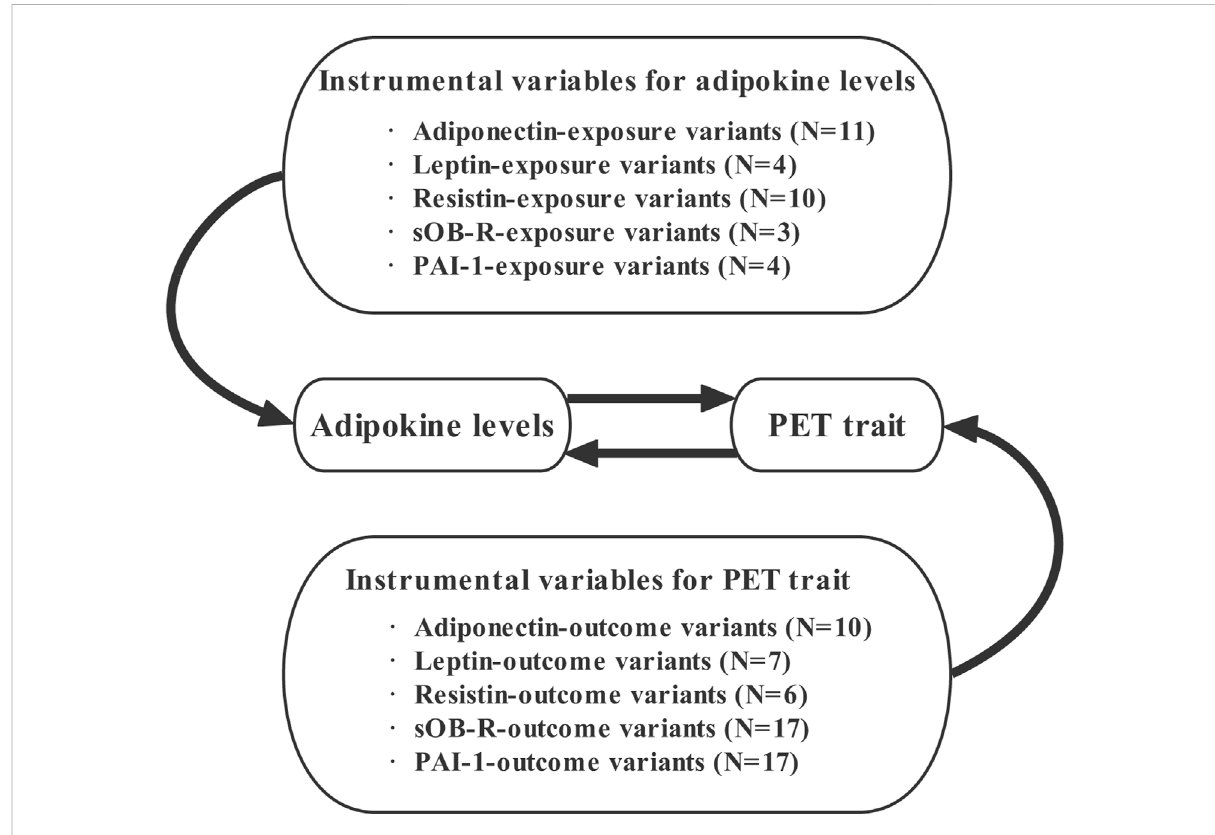
FIGURE 1 Overview of our study design aimed at revealing the bidirectional relationships between circulating adipokines and PET. Abbreviations: N, number of SNPs; PET, preeclampsia or eclampsia.